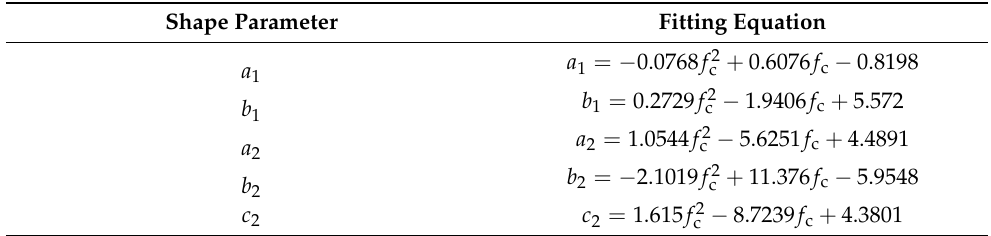
Table 8. Calculation formula for the shape parameters of the constitutive equation